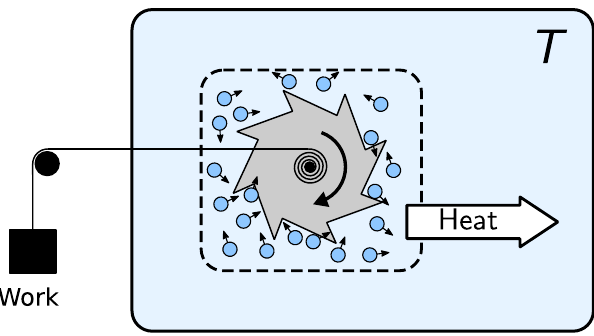
FIG. 1. Schematic representation of an autonomous engine driven by active matter. An asymmetric cog-shaped passive obstacle (gray) rotates persistently in contact with a bath of active particles (dark blue). Applying an external load opposed to the spontaneous rotation, for instance, by connecting the rotation axis to an external weight, the system produces work by lifting the weight. Besides, both the obstacle and the active particles are in contact with a thermostat at fixed temperature T , so that heat is constantly dissipated in the energy reservoir (light